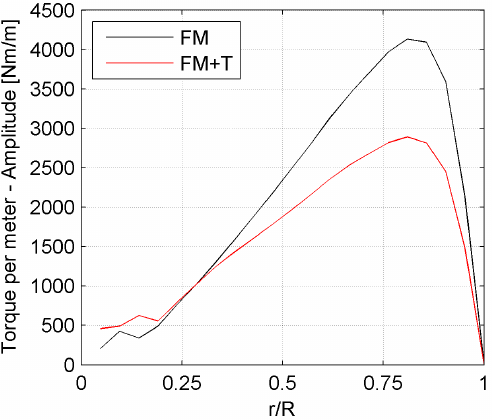
Figure 15. Amplitude of the torque oscillation as a function of the span: FM vs. FM + T.